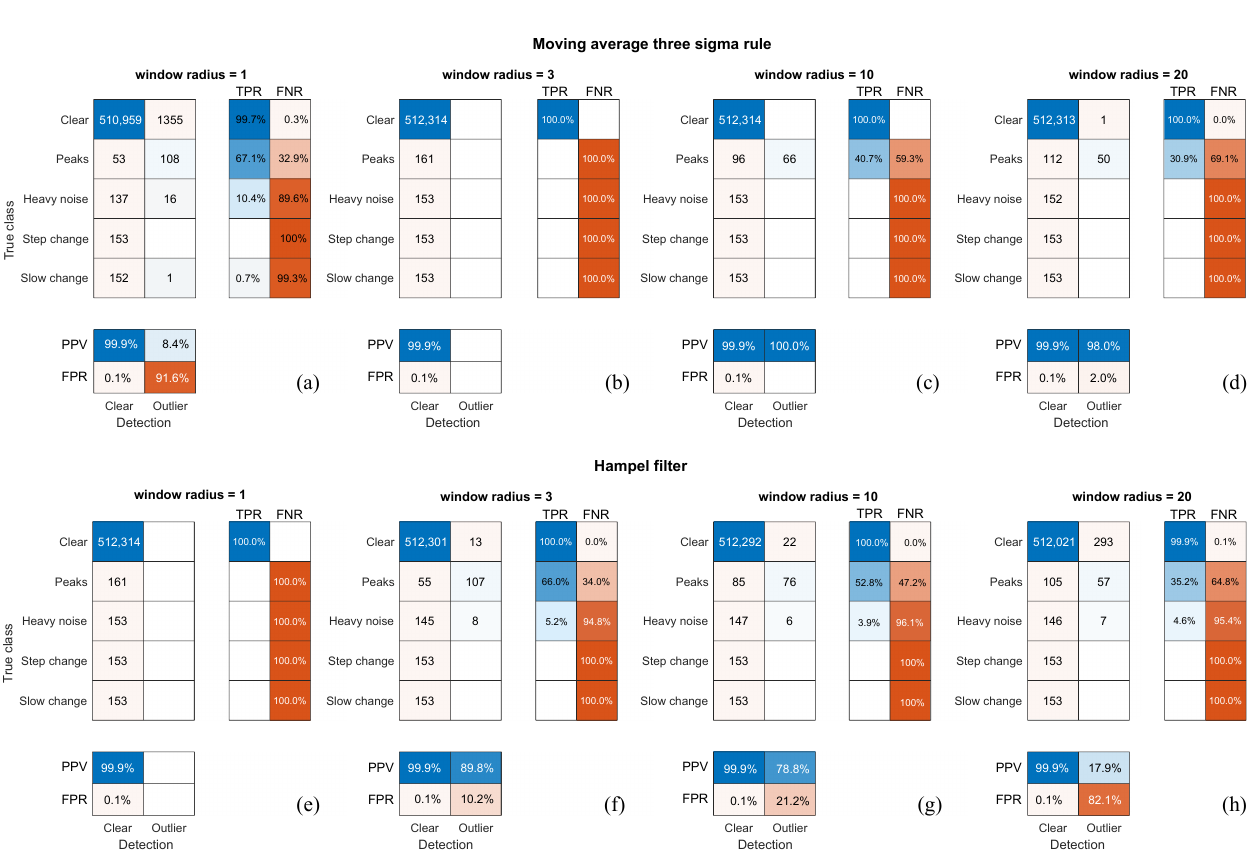
Figure 15. Averaged confusion matrix for detection with M3S ( a – d ) and the Hampel filer ( e – h ) of synthetic anomalies for a 1000-fold simulation with 10-mm average amplitudes of distortions and a share 20% of the time (blue—successful results,